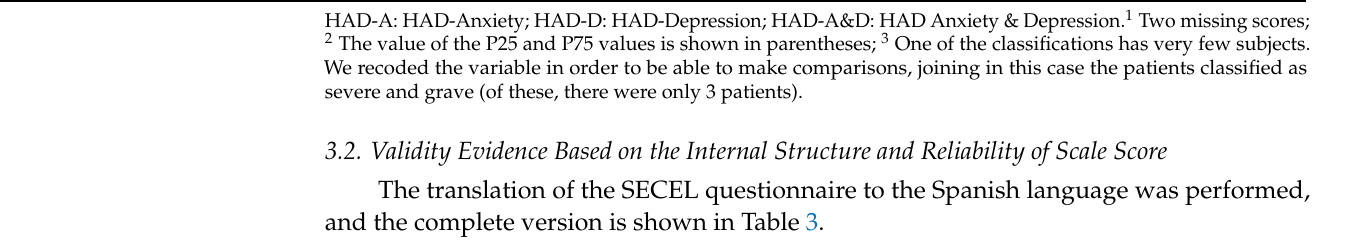
Table 3. SECEL original and Spanish version (S-SECEL, preview version). The 35 items are shown after the process of translation and cultural